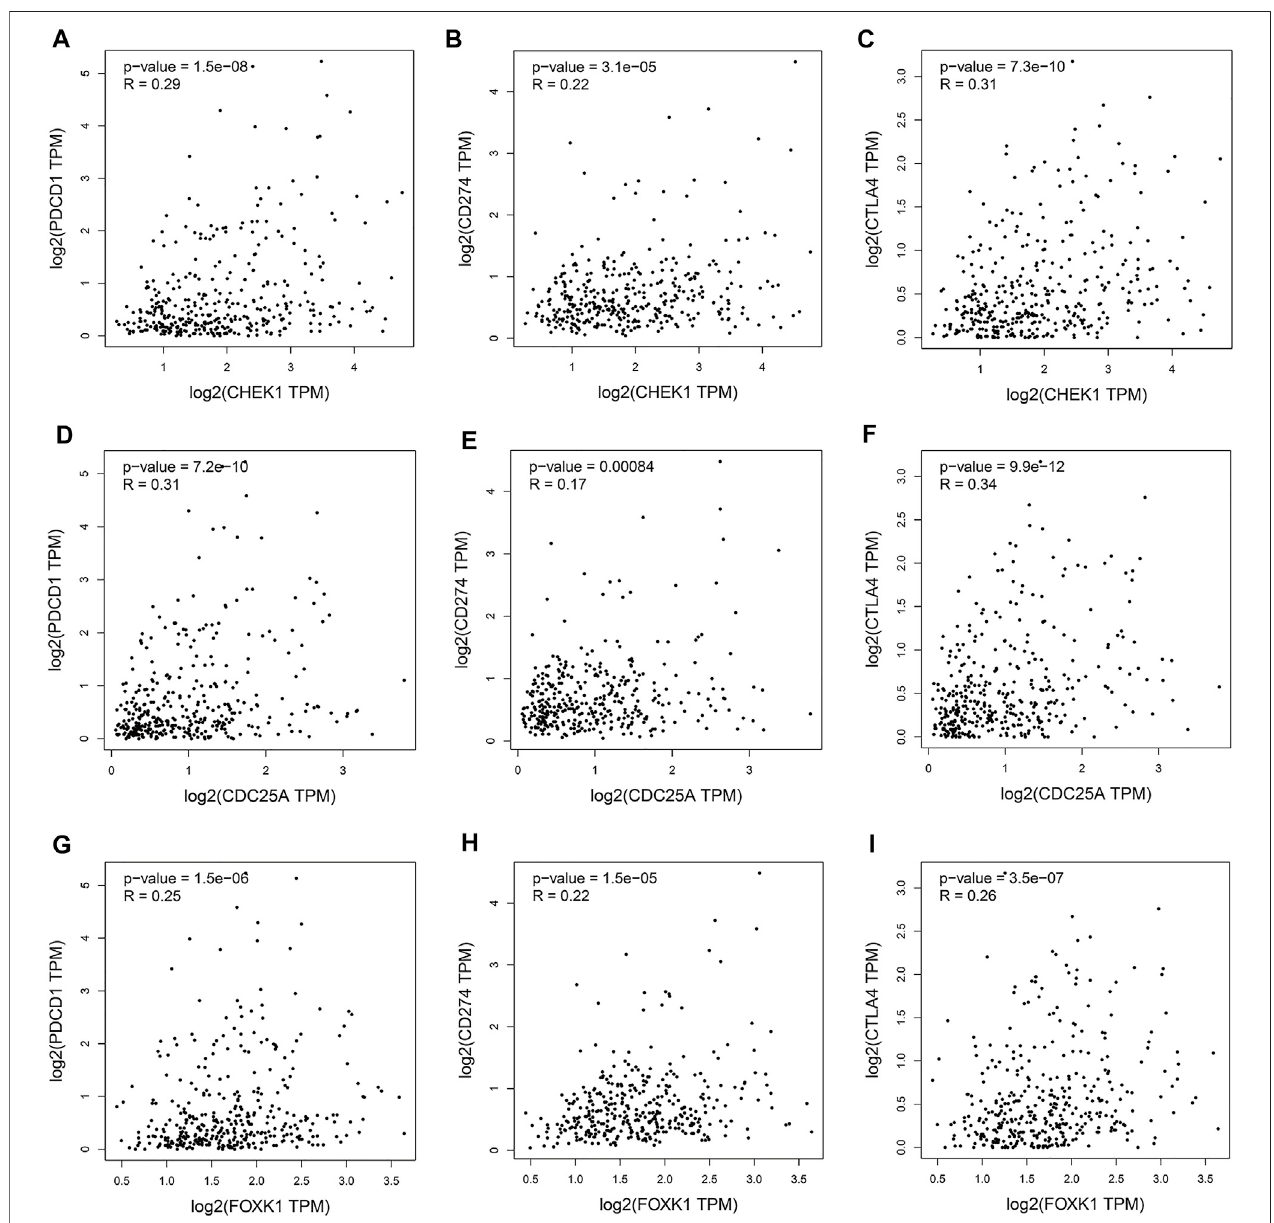
FIGURE 10 | Associations of the expression of CHEK1 (A – C) , CDC25A (D – F) , FOXK1 (G – I) in the ceRNA network with the expression of immune checkpoints in LIHC.